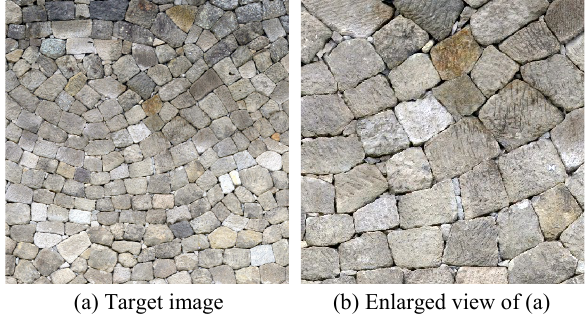
Figure 3. Orthographic projected elevation image of castellated wall used for comparison in processing